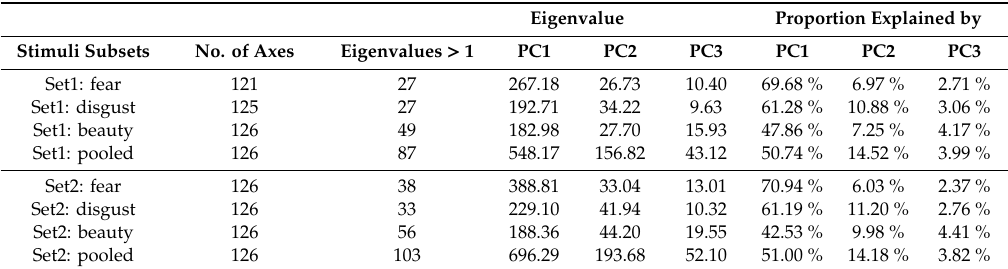
Table 1. Summary of the principal component (PC analysis of the